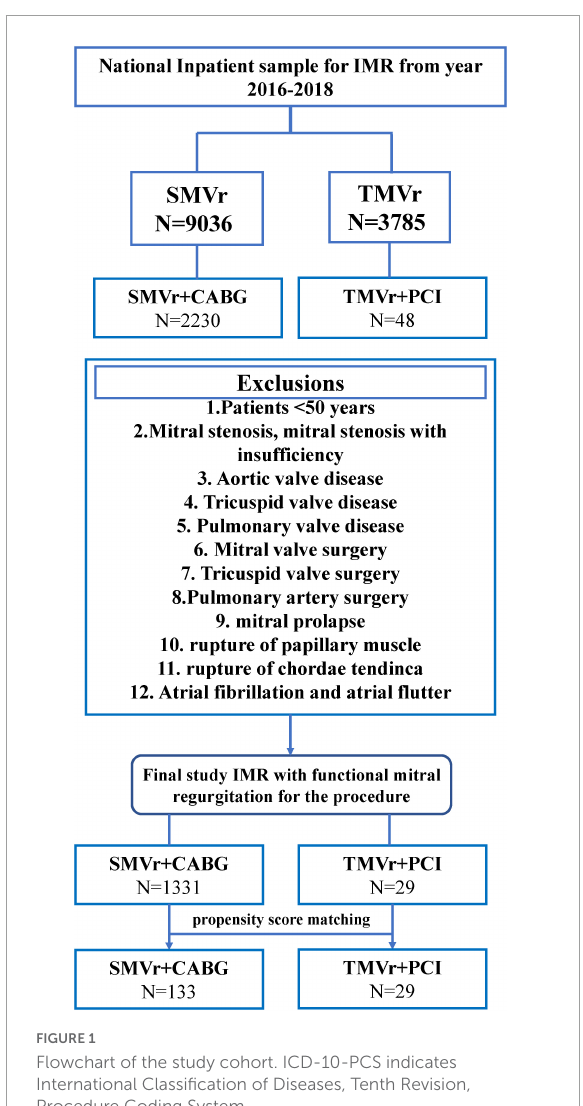
FIGURE1 Flowchart of the study cohort. ICD-10-PCS indicates International Classification of Diseases, Tenth Revision, Procedure Coding